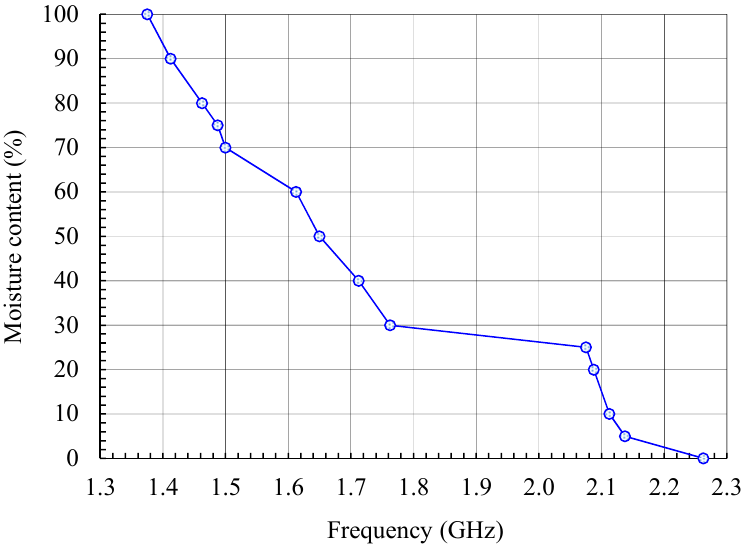
Figure 17. Calibration curve connecting the resonant frequency and moisture content for the textile PIFA. The markers indicate measured values.